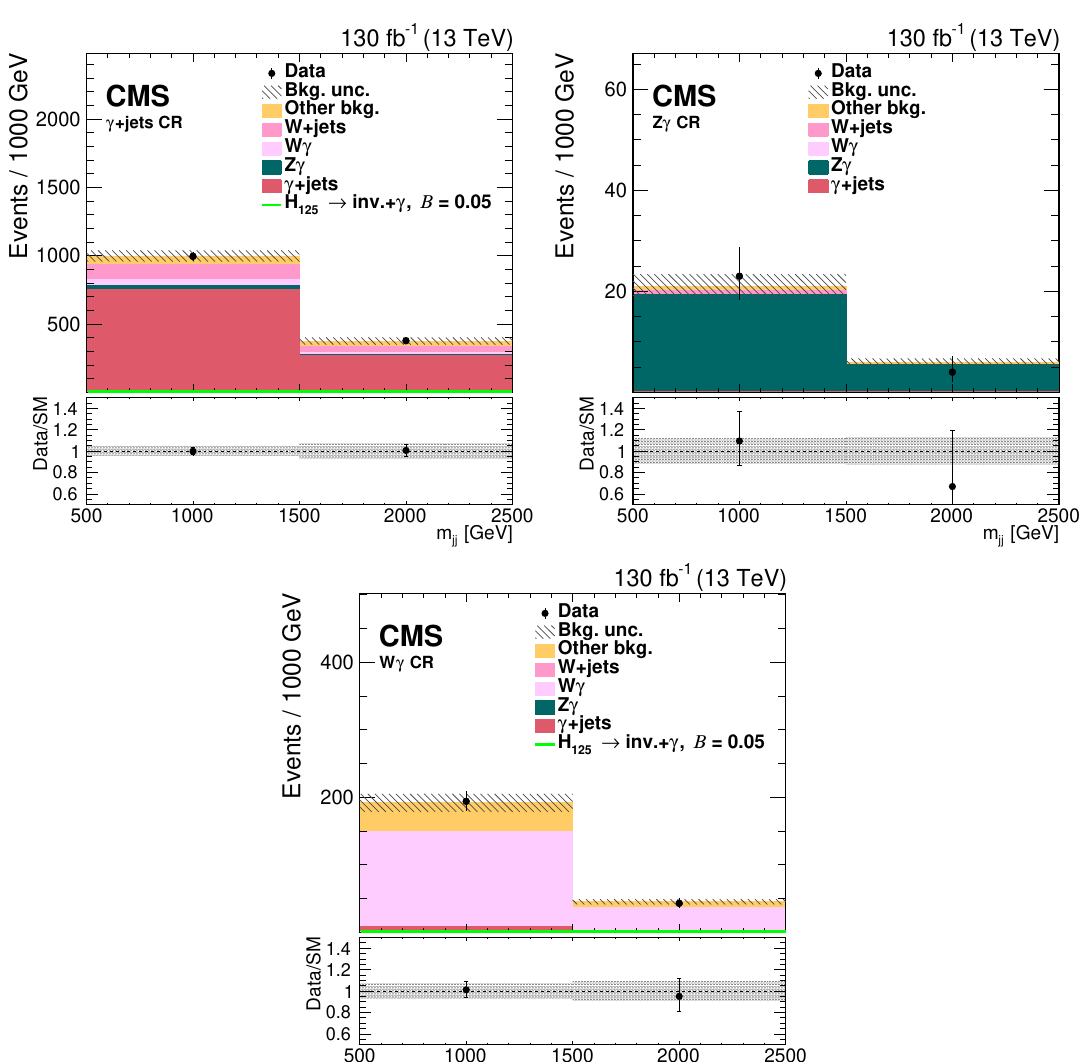
Figure 2 . The m distributions from the simultaneous fit in the g + jets (upper left), Z( m + m − ) + g jj (upper right), and W( mn ) + g (lower) CRs. The category other background includes contributions from Z + jets, nonprompt, top quark, VV , and VVV processes. Overflow events are included in the last bin. The shaded bands represent the combination of the statistical and systematic uncertainties in the predicted yields. The light green line, illustrating the possible contribution expected from inclusive SM Higgs boson production, assumes a branching fraction of 5% for H → inv. + γ decays. The lower panel in the figures shows a per-bin ratio of the data yield and the background expectation. The shaded band corresponds to the combined systematic and statistical uncertainty in the background